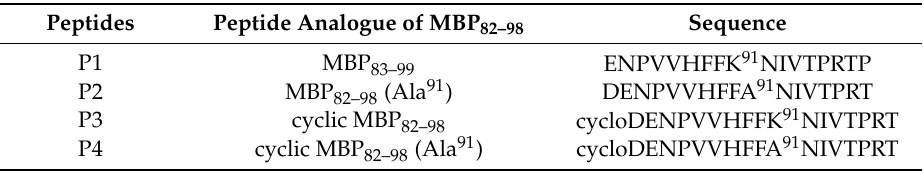
Table 1. Peptide analogues and their one-letter amino acid